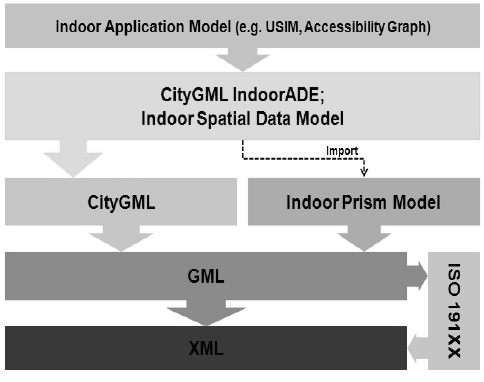
Figure 4. Poincare duality of 3D objects and relationship between 3D objects